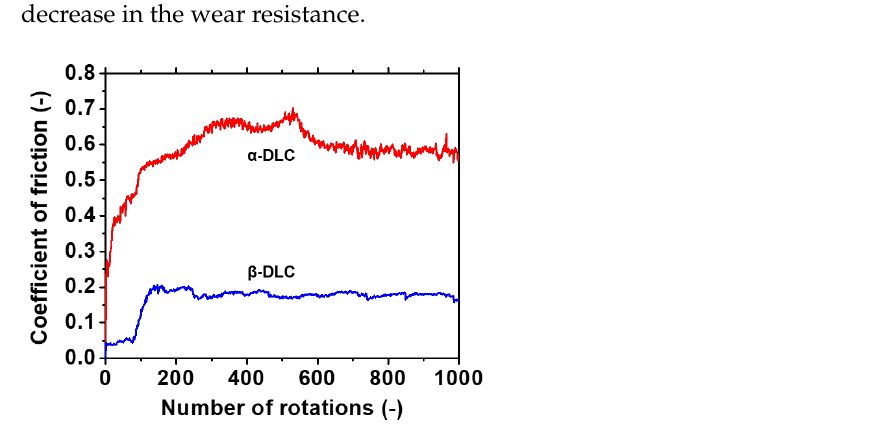
Figure 10. Results of the BoD test for the heat-treated (25 °C, 46% RH) and non-heat-treated (27 °C, 54% RH) samples in group A.